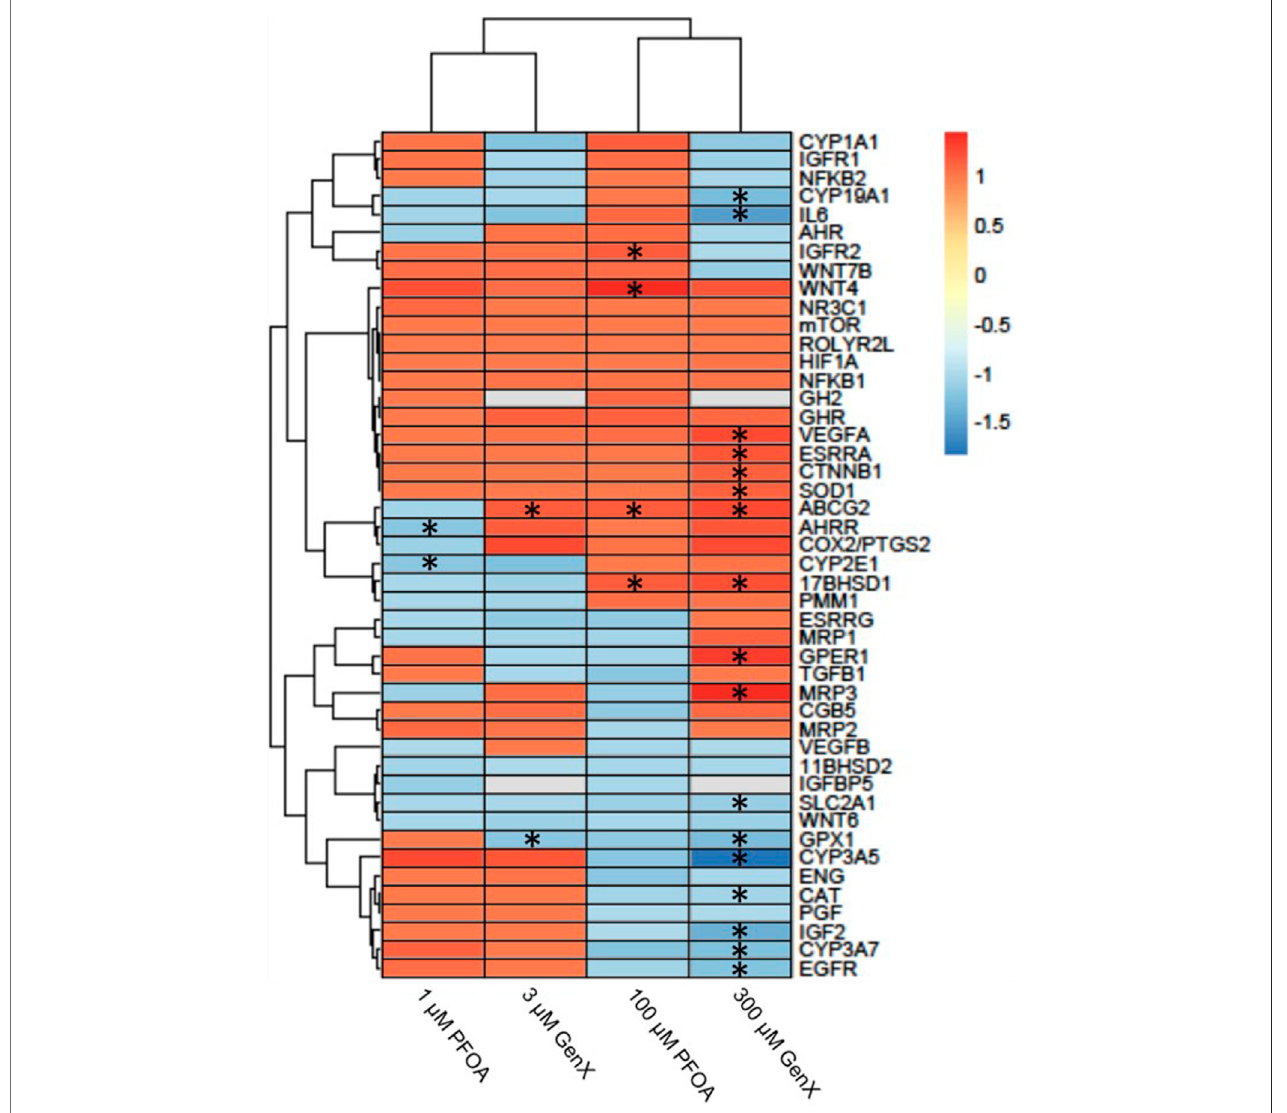
FIGURE 6 | Heatmap illustrating gene expression changes in a set of 46 genes evaluated in JEG-3 cells after exposure to PFOA or GenX for 24 h. Fold-change is indicatedbythescalebarandcolorsontheheatmap,withgreyindicatinggeneswithmRNAcountsbelowthedetectionthresholdduetosuboptimalprobehybridization ( GH2 and IGFBP5 ). Experimental group fold-change values were compared to corresponding vehicle control group fold-change values by ANOVA. Asterisks indicate signi fi cant shifts in gene expression at a false discovery rate of * p < 0.05 (N = 3 biological replicates).